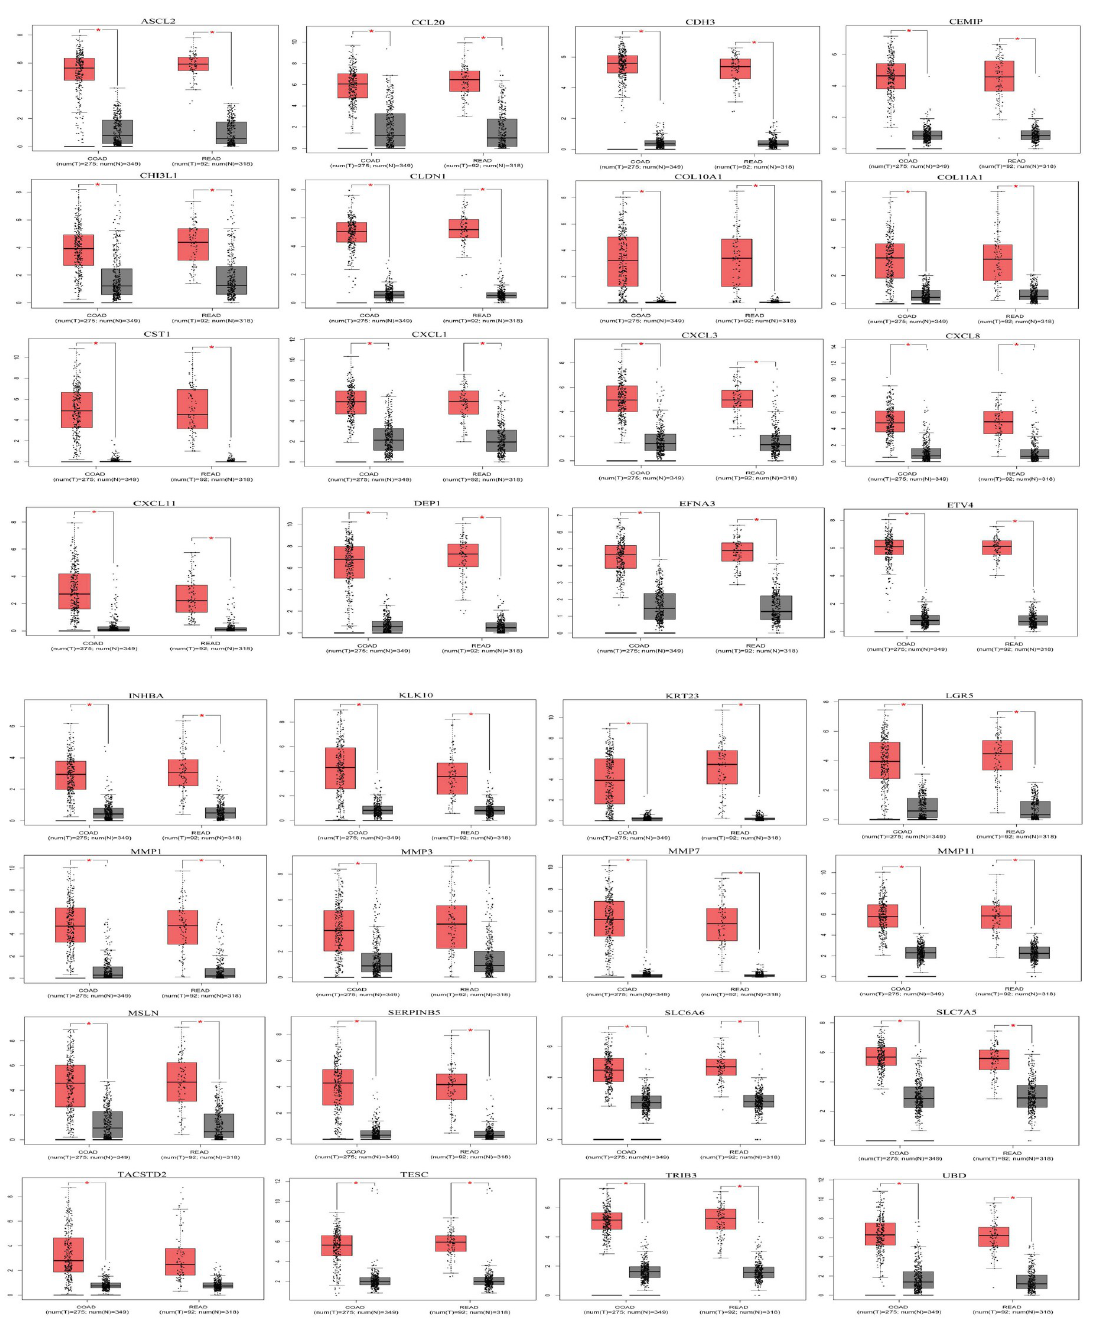
Fig 15. Expression box plots of statistically significant over-expressed validated Differentially Expressed Genes based on TCGA data.